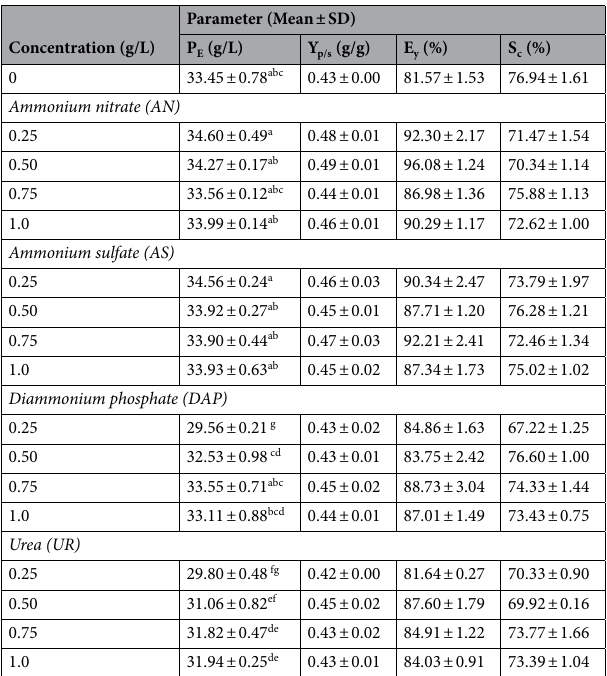
Table 3. Kinetic parameters of ethanol production from PWH supplemented with various inorganic nitrogen sources and concentrations at 40 °C for 18 h. P E : ethanol concentration (g/L); Y p/s : ethanol yield (g/g); E y : yield efficiency (%); and S c : sugar consumption (%). Mean values with different letters in the same column are significantly different ( p value < 0.05) based on DMRT